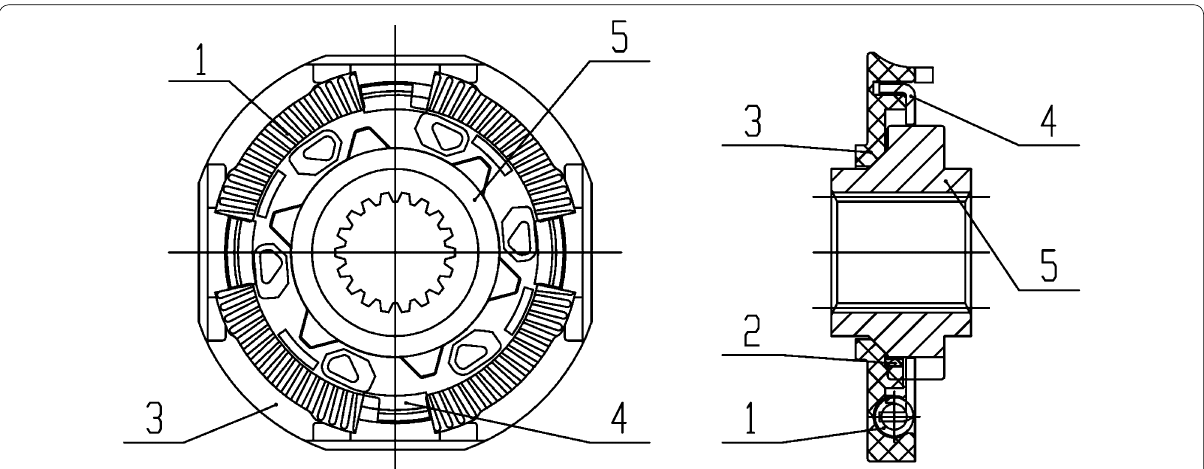
Figure 11 Schematic illustration of novel split pre-damping structure. 1. Pre-damping spring, 2. Rubber pad, 3. Rear hysteresis plate, 4. Pre-damping hub plate, 5. Hub